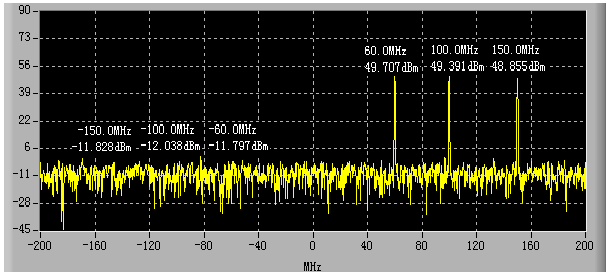
Figure 11. Frequency spectrum of the three-tone signal after LPI compensation.